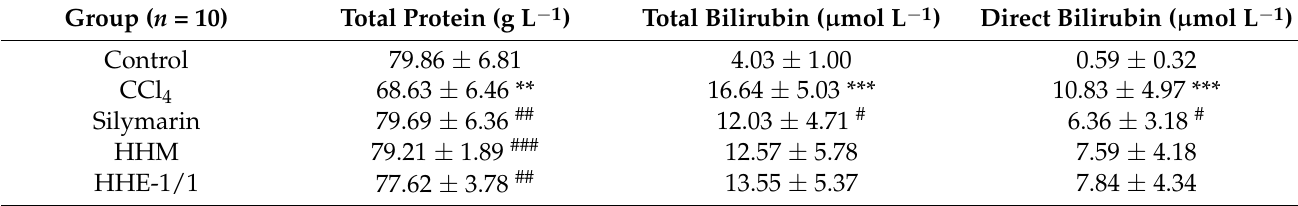
Table 3. HHM and HHE-1/1 effect on total protein and bilirubin of CCl 4 -induced liver